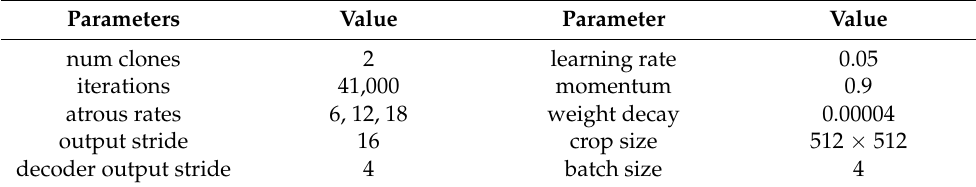
Table 2. Training